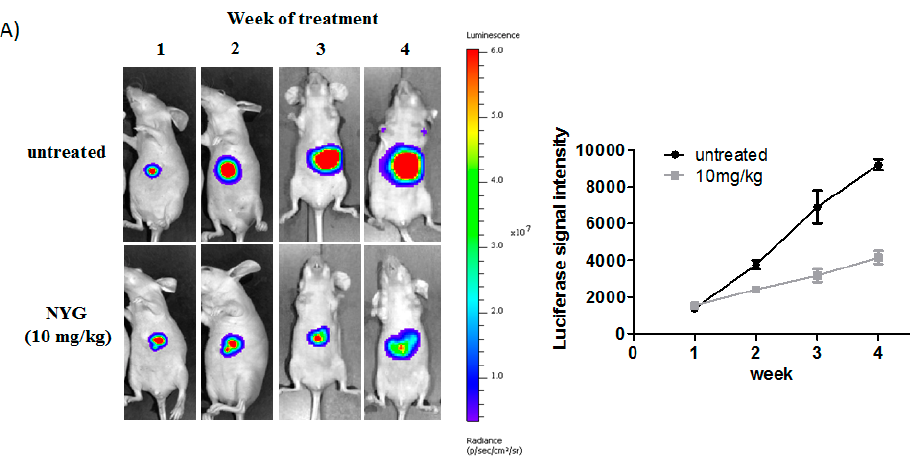
Figure 2. Cont. Figure 2.